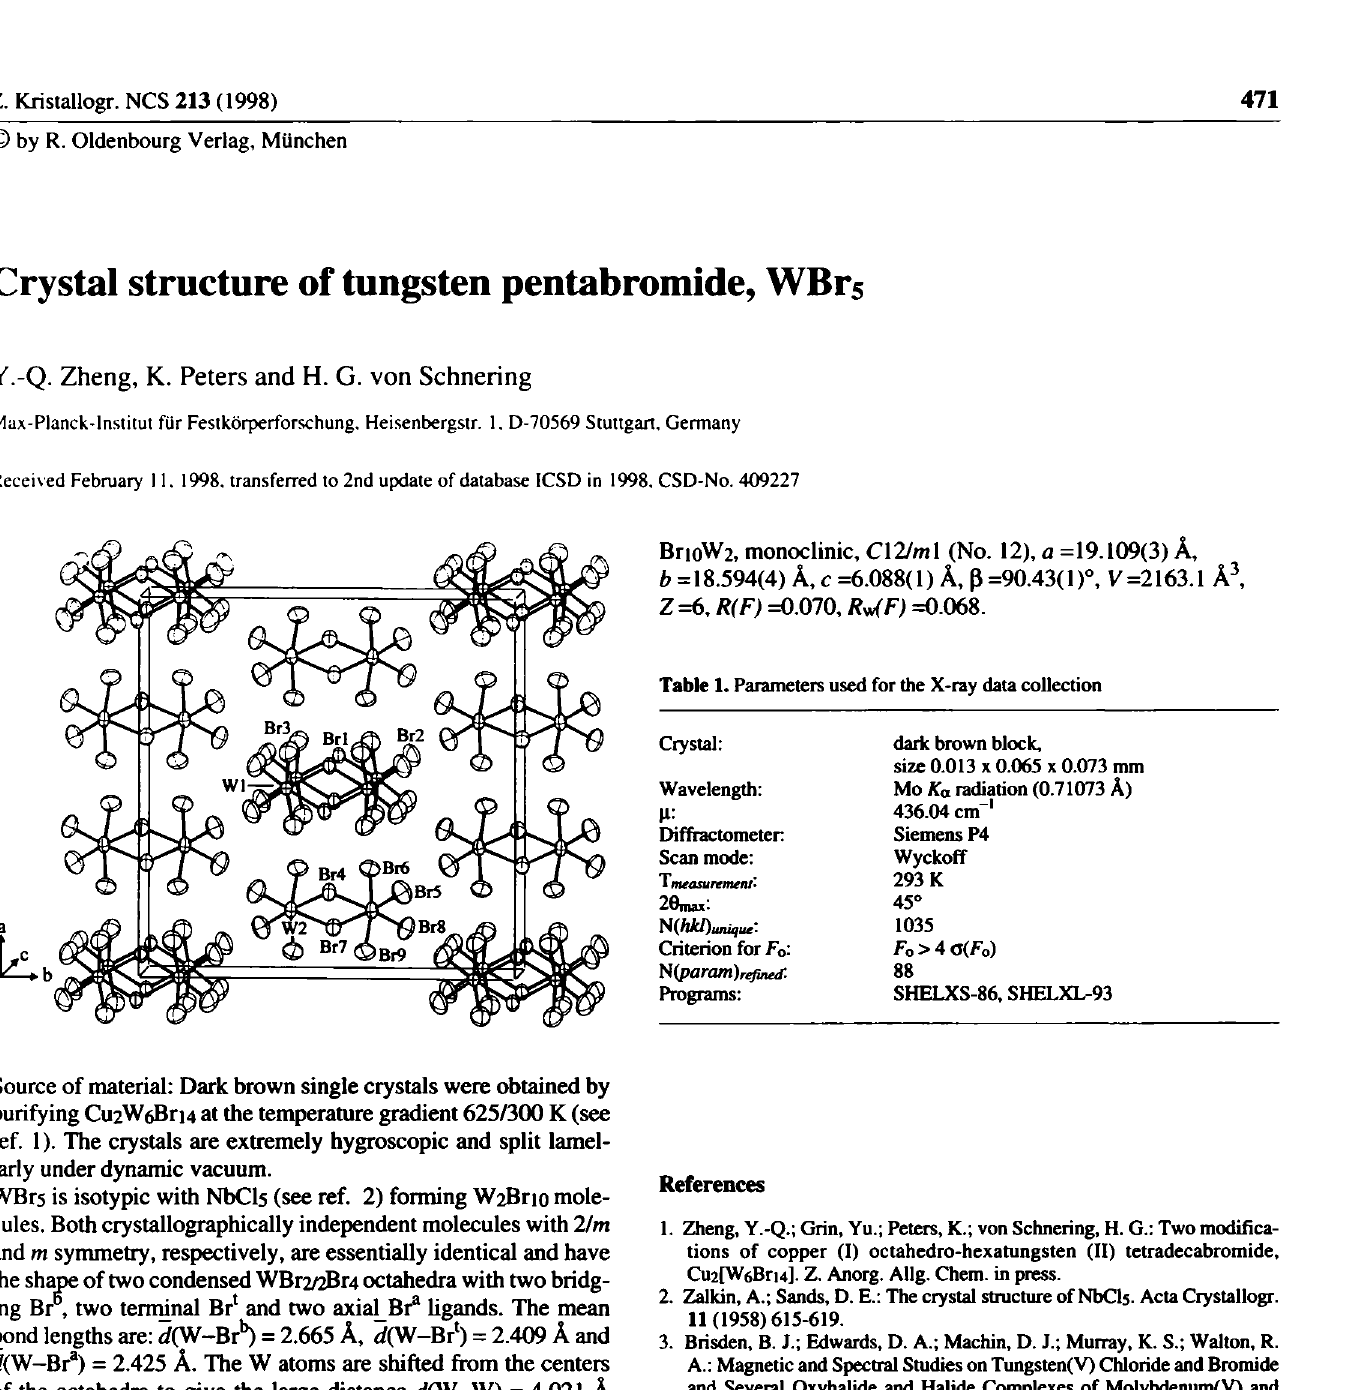
Table 2. Final atomic coordinates and displacement parameters (in